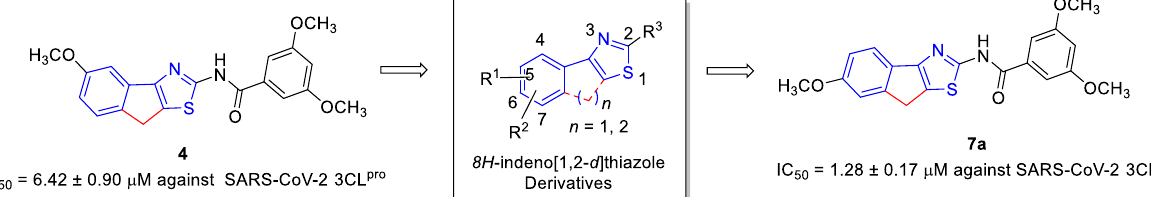
Figure 2. Structure of 8 H -indeno[1,2- d ]thiazole derivatives.